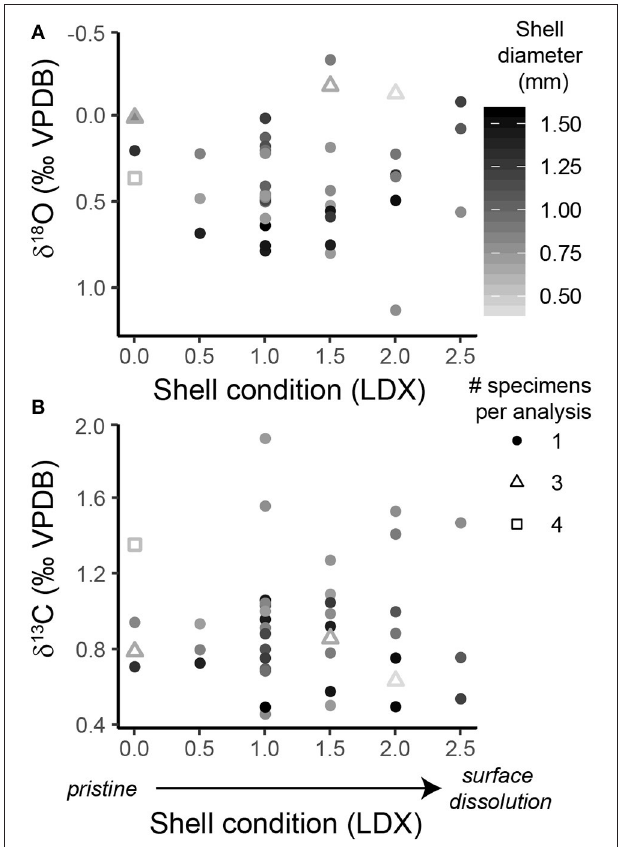
FIGURE 2 | Scatter plots of the shell condition of H. inflatus shells from the sediment trap, assessed using the Limacina Dissolution Index (LDX: 0 = pristine, 5 = highly altered), and (A) the δ 18 O and (B) δ 13 C of the shells. Following convention, the δ 18 O axis is inverted. The color of the points corresponds to the shell diameter. The shape of the point represents the number of specimens pooled per isotopic analysis (see key in figure).